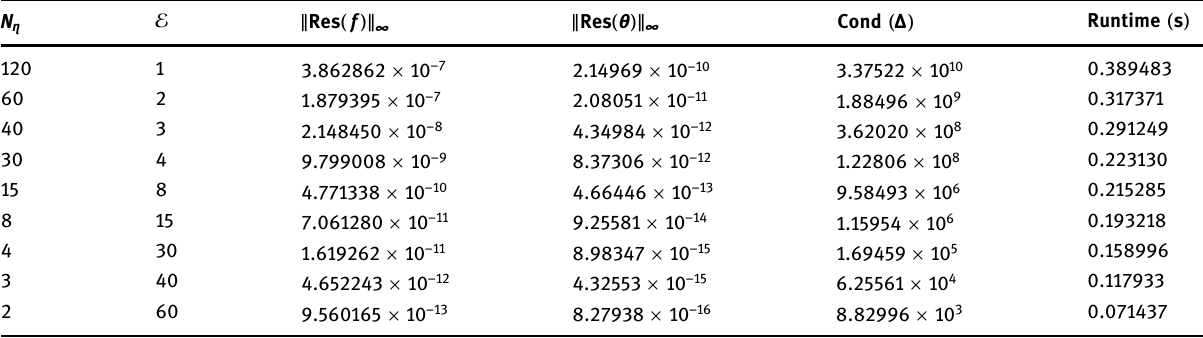
Table 7: Condition numbers, residual error values, and execution time when N η and (cid:2) are